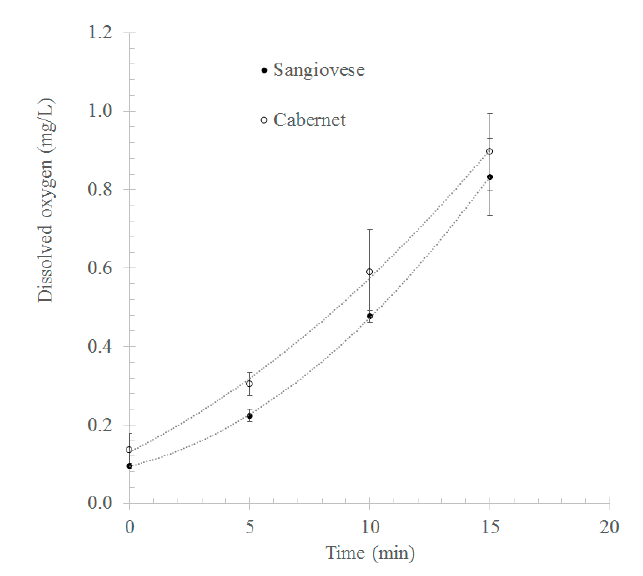
Figure 2. Time course of dissolved oxygen in wine after opening (time zero).